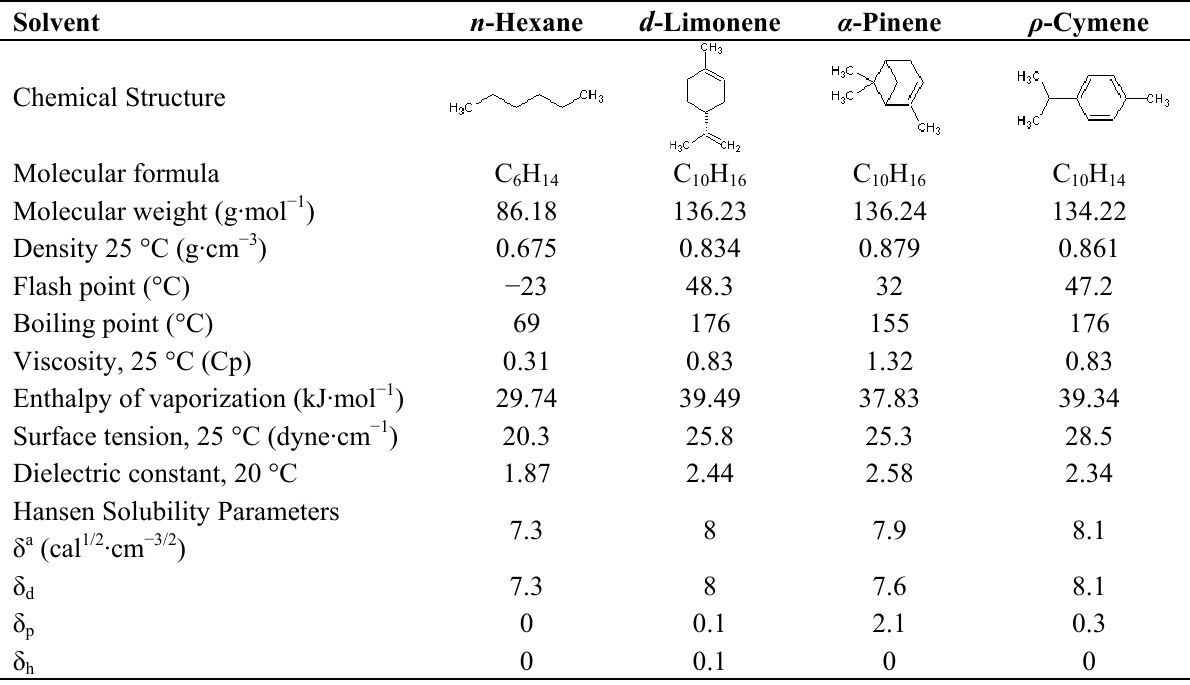
Table 1. Relevant properties of n -hexane and